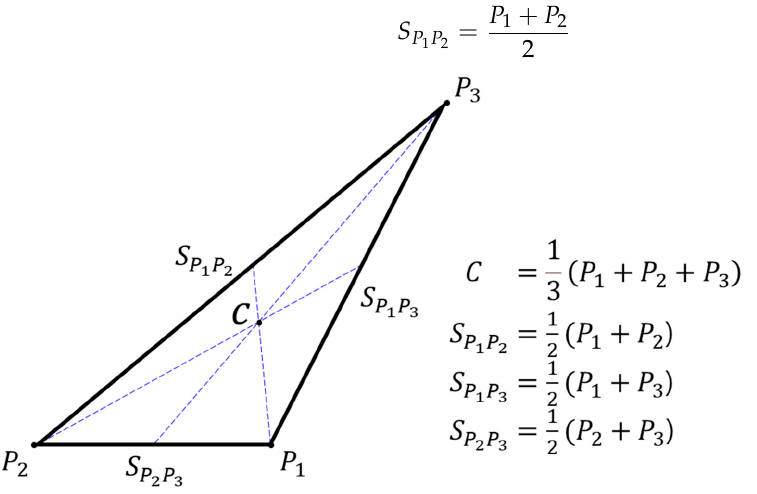
Figure 5. Triangle centroid formulation by Abraham Albert Ungar in August 2010